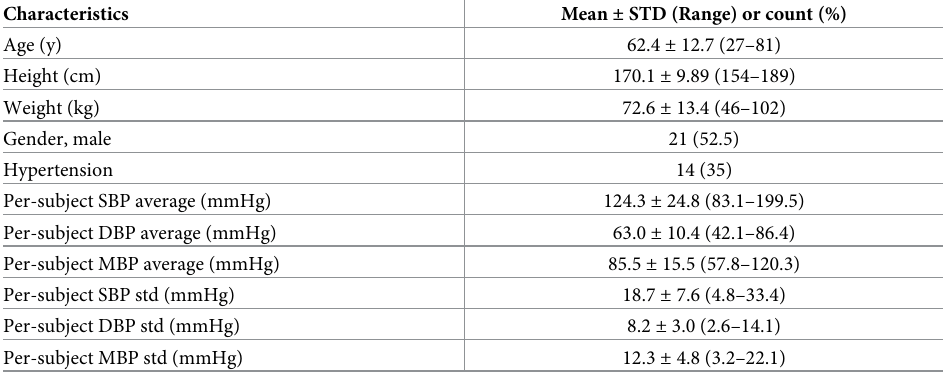
Table 1. Demographic and BP